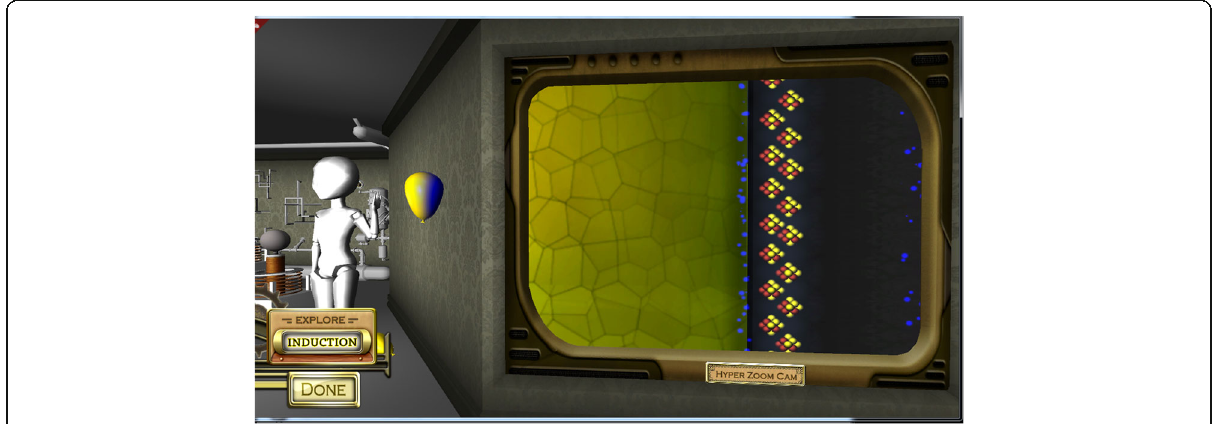
Fig. 5 The negative electrons on the balloon push the negative electrons on the wall deeper into the wall, so the balloon can bond momentarily with the slightly more positive wall